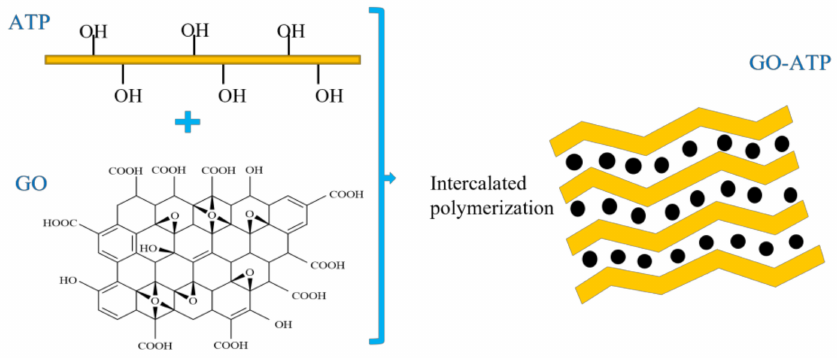
Figure 1. Preparation process and structure of GO −